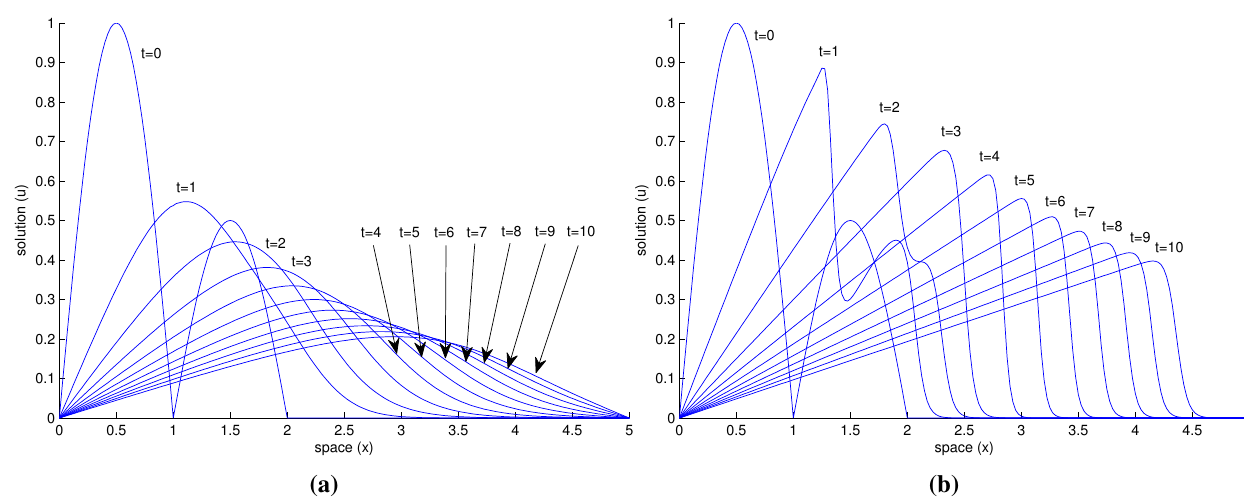
Figure 2. Solution for different times and ε values, both of them with n = m = 200 and t = 10 . ( a ) ε = 0 . 1 ; ( b ) ε = 0 . 01 . max Table 4. Numerical results of the approximated solution for different values of x, t and ε . x t ε = 0 .